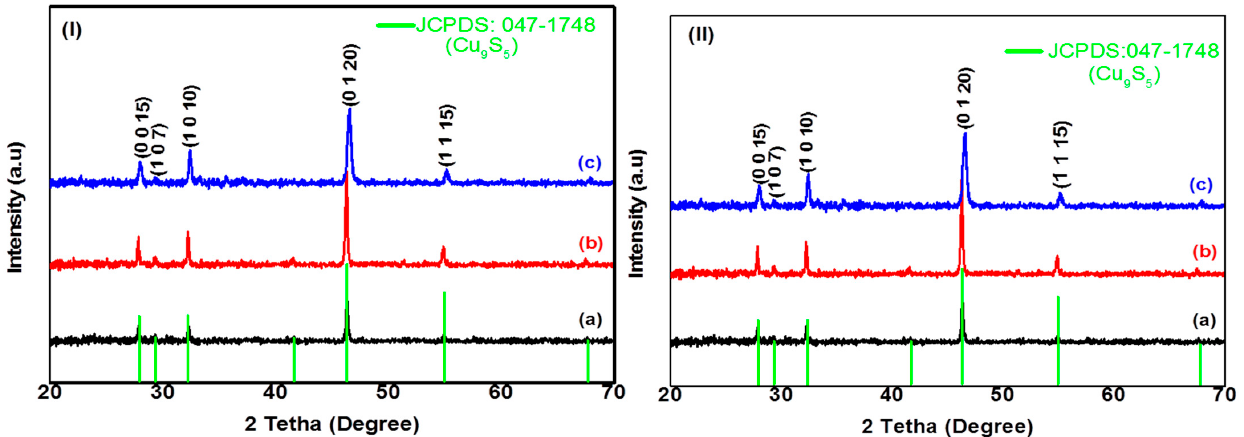
Figure 3. p-XRD patterns of Cu x S y nanoparticles prepared in (a) OLA, (b) HDA, and (c) DDA at 230 ◦ C using ( I ) complex 1 and ( II ) complex